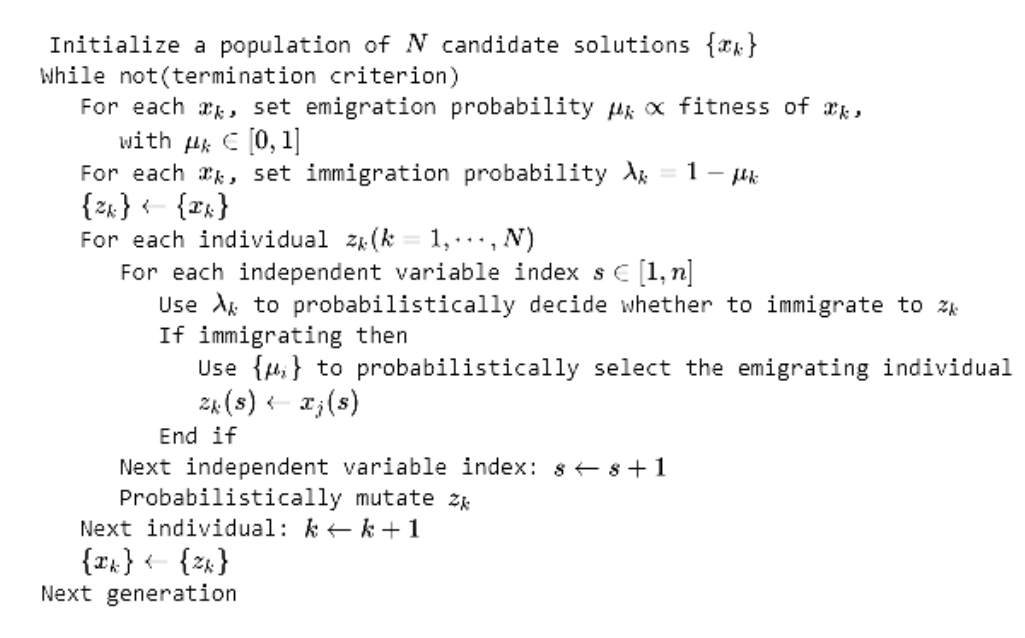
Figure 3. Algorithm for biogeography based optimization (BBO).